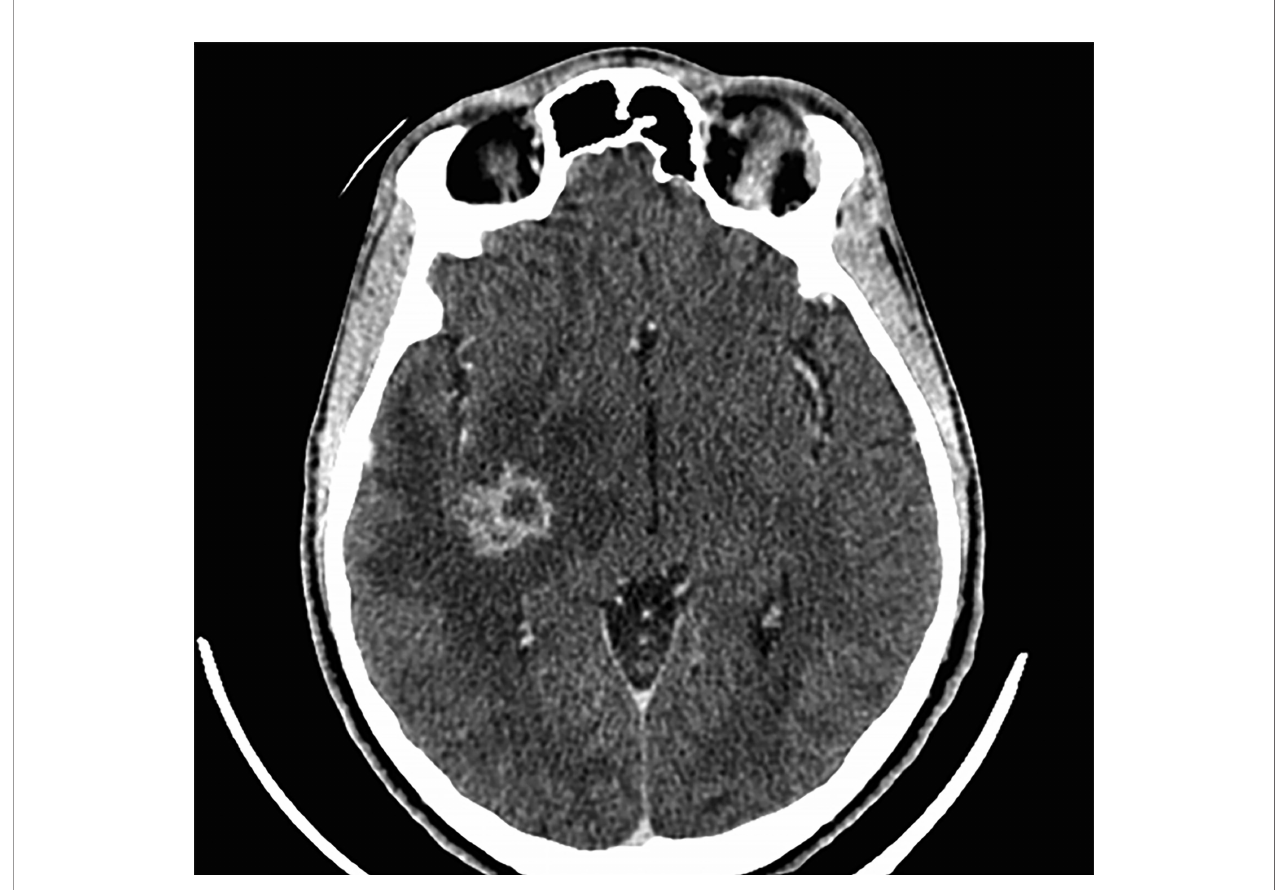
FIGURE 1 | Brain Computed Tomography-scan with nodular, right insular lesion with cocoon enhancement and peri-lesional